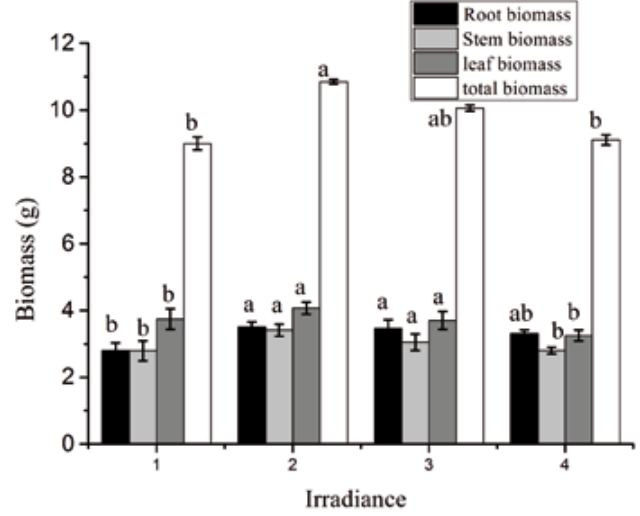
Fig. 1: Dry biomass of M. breviracema plant grown under different light intensities. The values are the average ± SE, and different letters indicate that there are obvious differences in the shade treatments